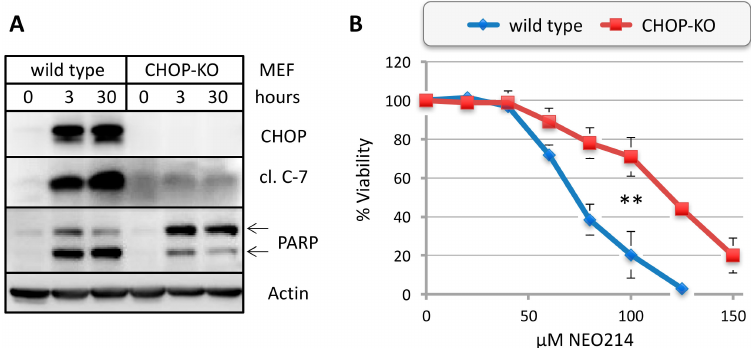
Figure 9. NEO214 requires CHOP for effective cytotoxic impact. Wild type or CHOP knockout ( CHOP -KO) mouse embryo fibroblasts (MEF) were treated with NEO214 and analyzed. ( A ) Cells were treated with 150 µ M NEO214 for different times, and cell lysates were analyzed by Western blot. ( B ) Cells were treated with increasing concentrations of NEO214 for 48 h, followed by determination of cell viability by MTT assay. Asterisks (**): p < 0.01 between wild type and CHOP -KO cells at NEO214 concentrations ≥ 80 µ